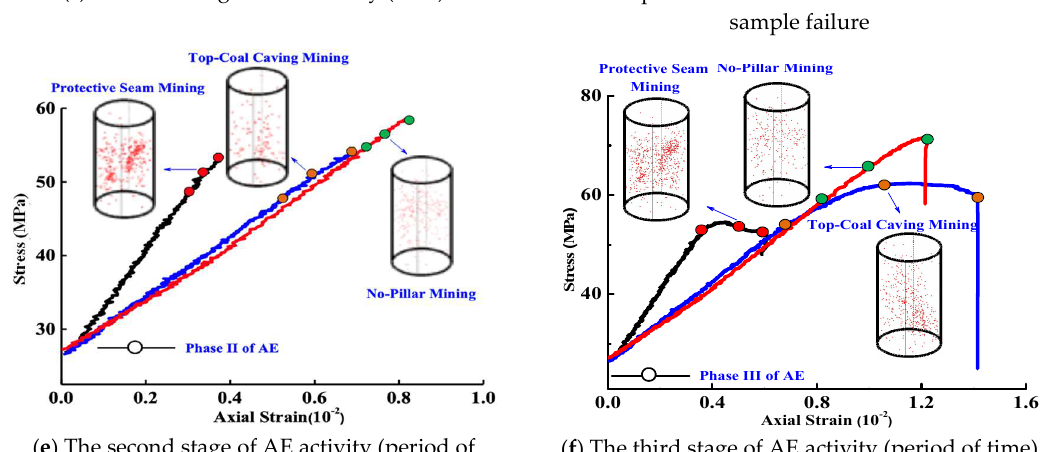
Figure 8. Spatial distribution of AE under different mining layouts.